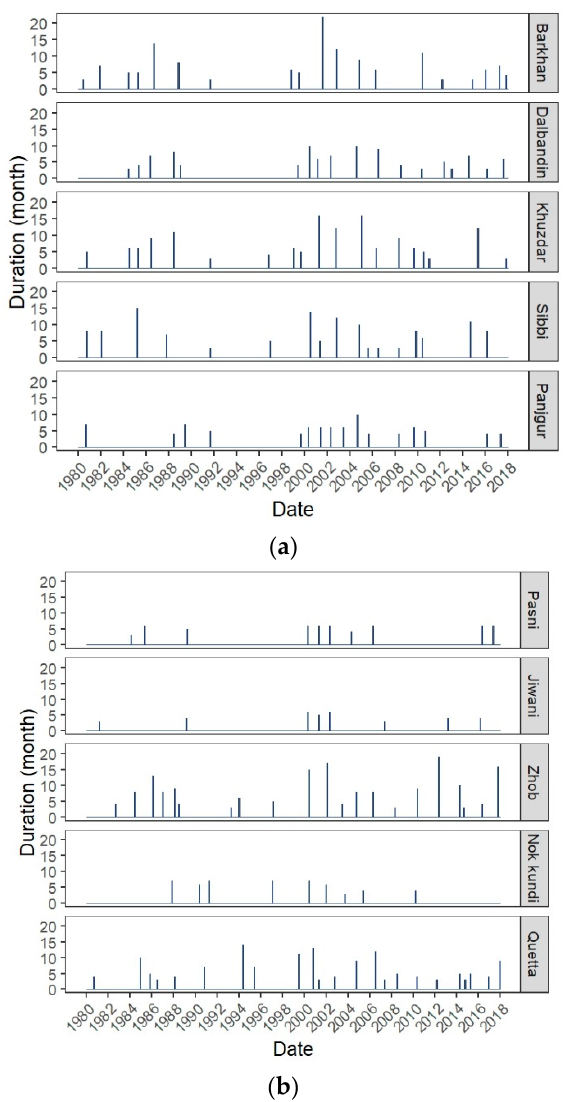
Figure 12. Drought durations at all stations.